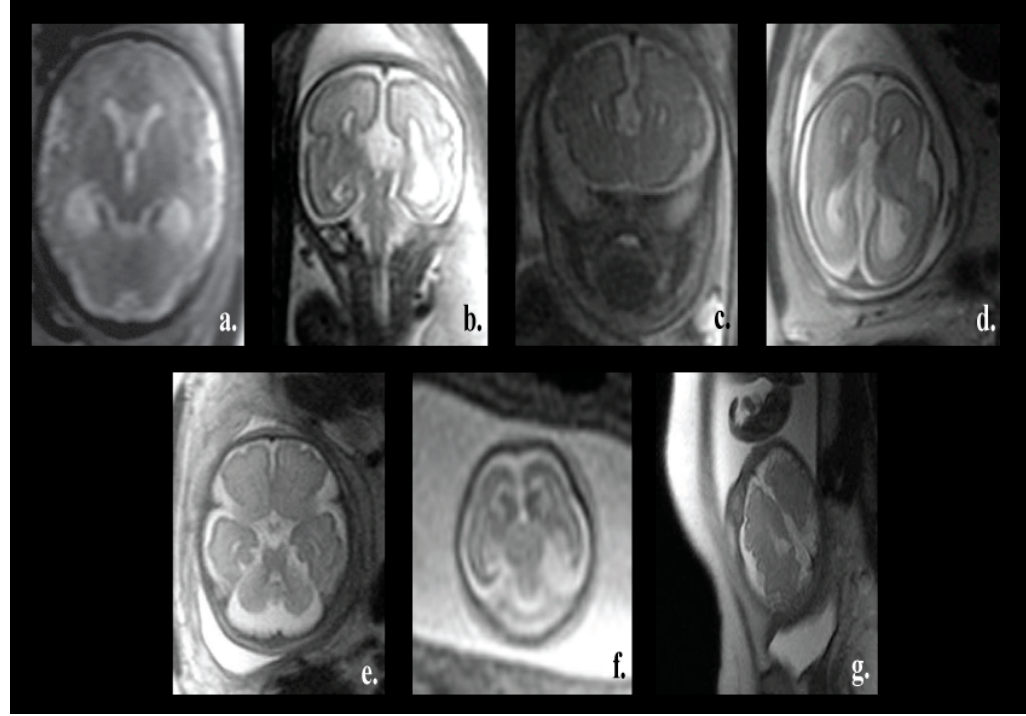
Figure 1. Different fetal brain abnormalities: ( a ) Agenesis of the septi pellucidi, ( b ) Dandy-Walker malformation, ( c ) colpocephaly, ( d ) agenesis of the corpus callosum, ( e ) mega-cisterna manga, ( f ) cerebellar hypoplasia, and ( g ) polymicrogyria .